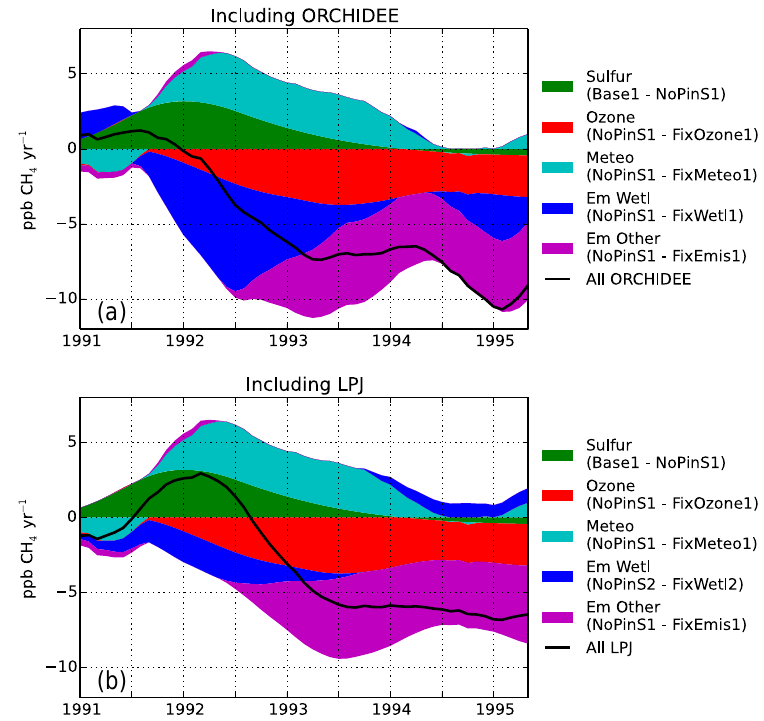
Figure 3. Global CH 4 growth rate variations with respect to the year 1990 induced by the different drivers, using (a) ORCHIDEE and (b) LPJ to represent variability in CH 4 emissions from wetlands. Simulations from Set I are used in both plots to infer the effect of stratospheric sulfur, stratospheric ozone, meteorology and emissions other than wetlands. Simulations from Set II are used only to infer the effect of LPJ emission variability. The overall variability (“All”) is calculated as the sum of the individual variations.